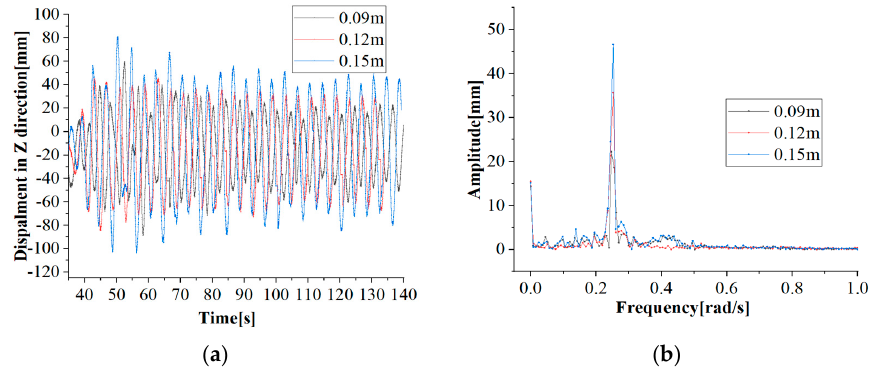
Figure 20. Heave response of the pedestal with different wave heights at 0.25 Hz. ( a ) Heave; ( b ) heave frequency domain curve.